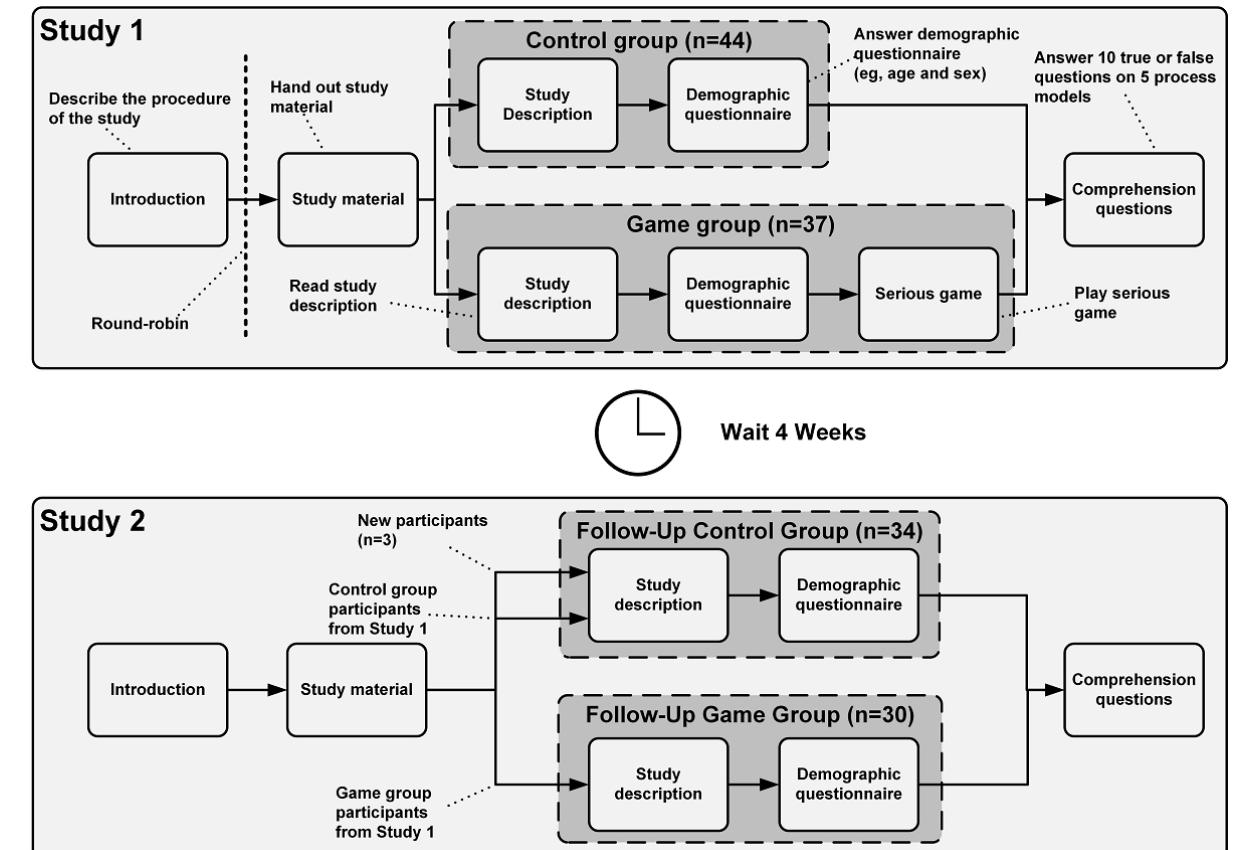
Figure 5. Study design.